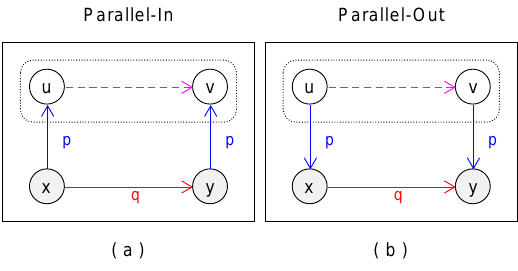
Figure 5. Extraction patterns with two predicates and three triples. ( a ) Parallel-In: u and v have in-coming connections (using p ) from x and y respectively. ( b ) Parallel-Out: u and v have out-going connections (using p ) to x and y respectively. In both patterns, x is connected to y using q